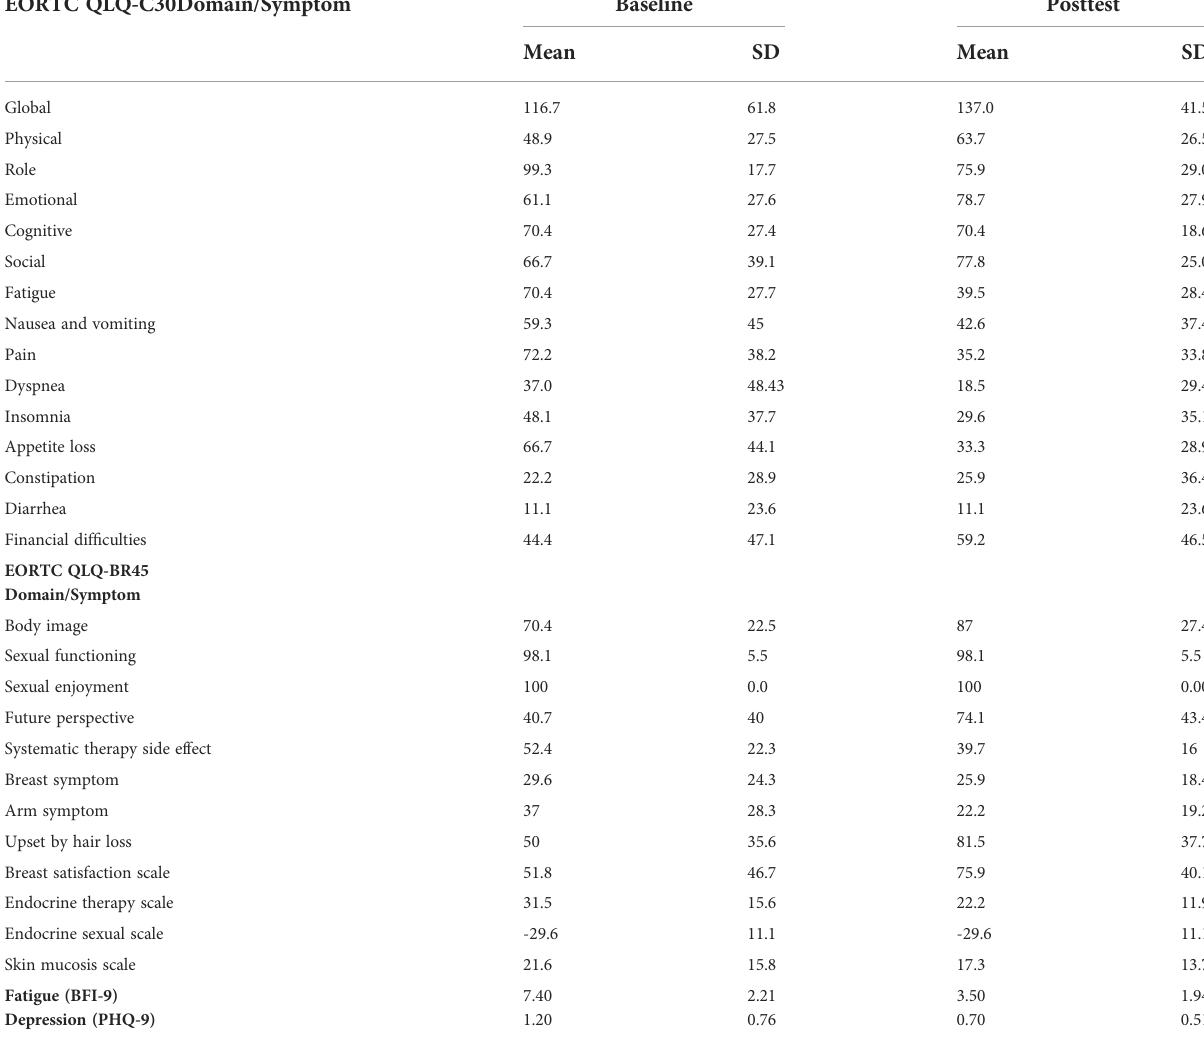
TABLE 4 The effect of Cognitive behavioural therapy integrated with activity pacing (CBT-AP) on fatigue, depression, and quality of life of breast cancer patients undergoing chemotherapy. EORTC QLQ-C30Domain/Symptom